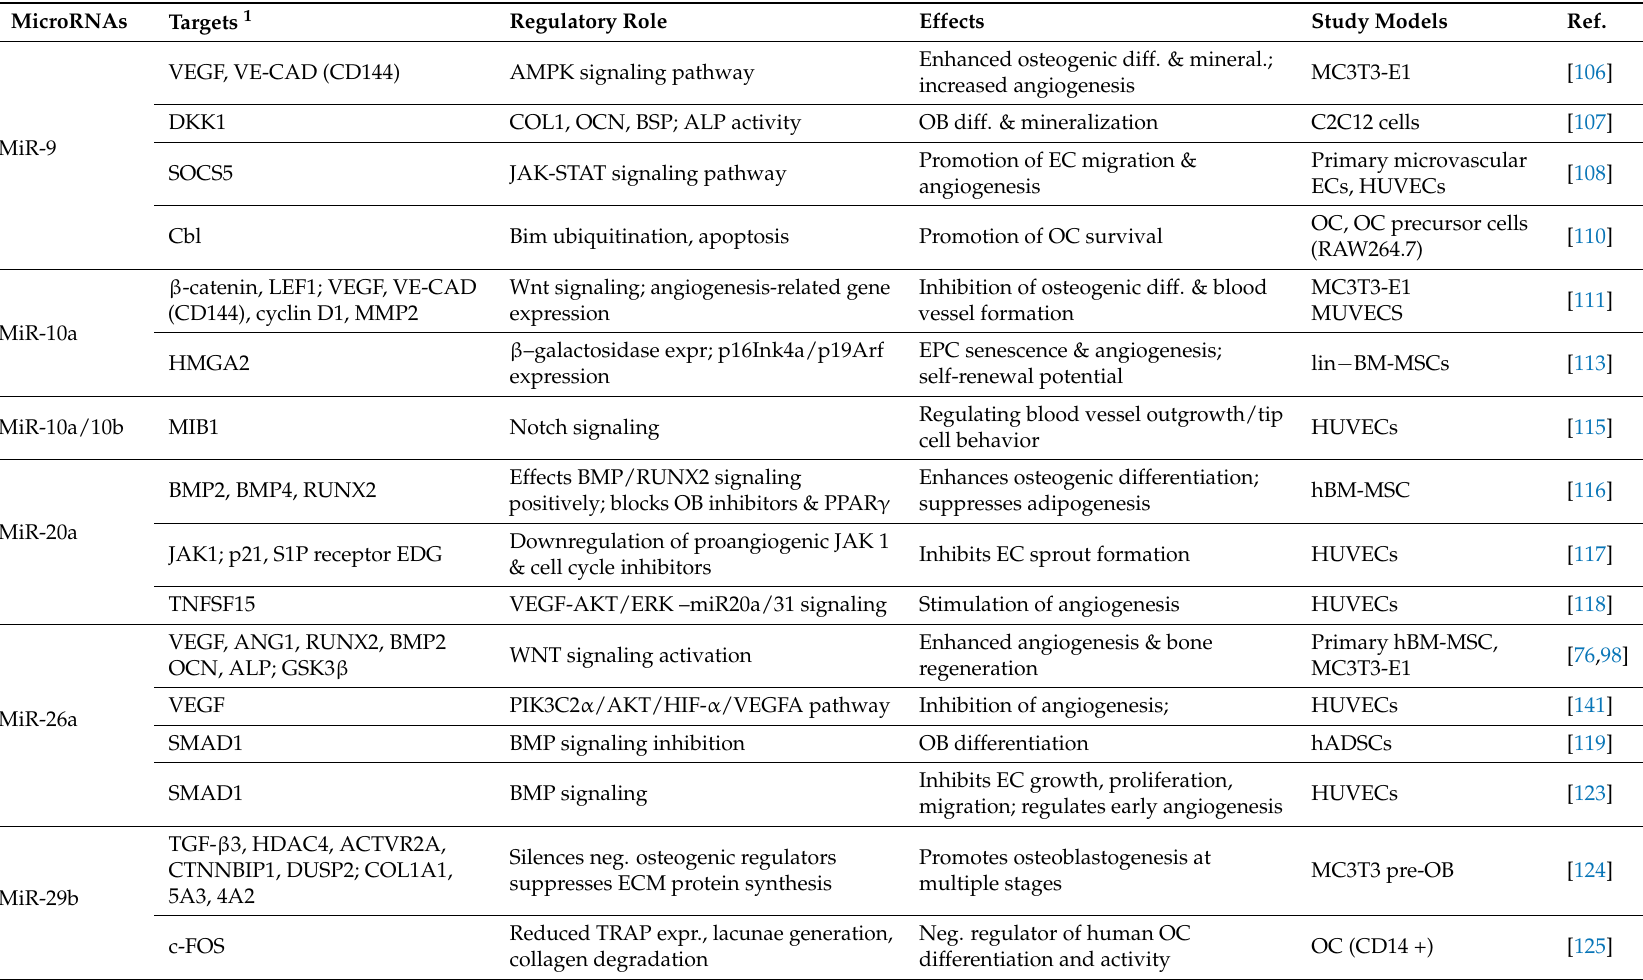
Table 1. Summary of microRNAs with a presumed role in osteogenic-angiogenic coupling paving the way for bone angiogenesis